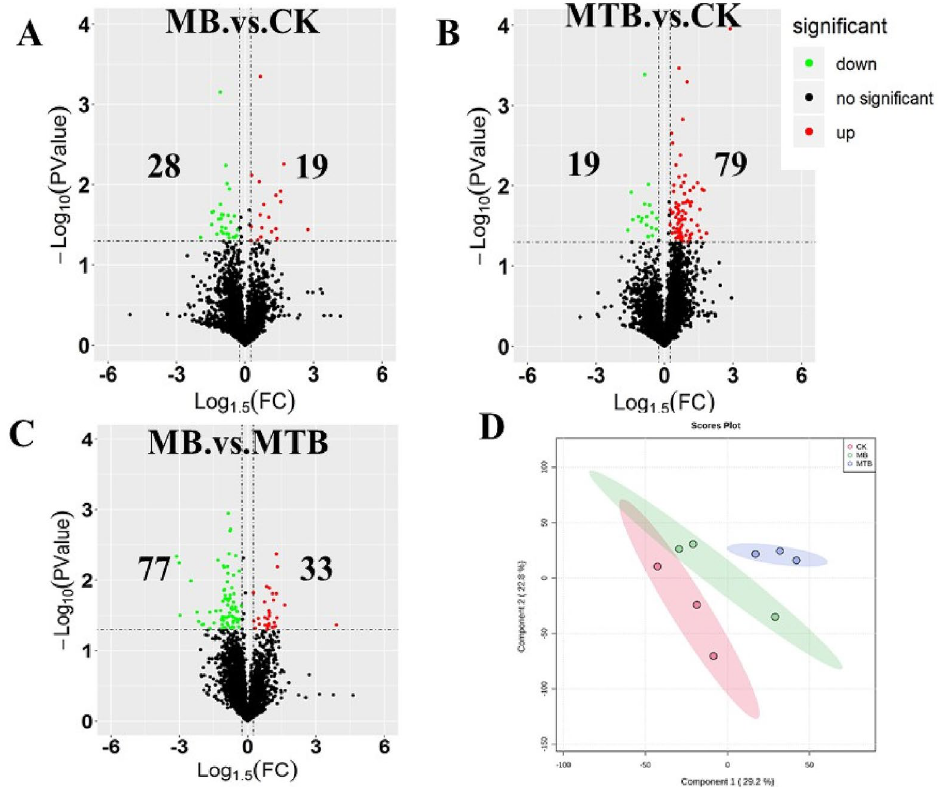
Figure 1. Overview of the alteration of lipid metabolisms of BAM following MTB and MB attacks. ( A – C ) Volcano plots of content alterations of lipids in each pairwise comparison ( A : MB. vs.CK; B : MTB. vs. CK; C : MB. vs. MTB). The gray points are lipids without significant alteration. The upregulated and downregulated lipids (|Log1.2(Foldchange)|> 1.0; P < 0.05) are labeled by red and green colors, respectively. ( D ) Principal component analysis represents the degree of separation of all samples and the stability between reproductions of each sample groups. Each circle represents a sample, the circles labeled by the same color indicates the samples with the same